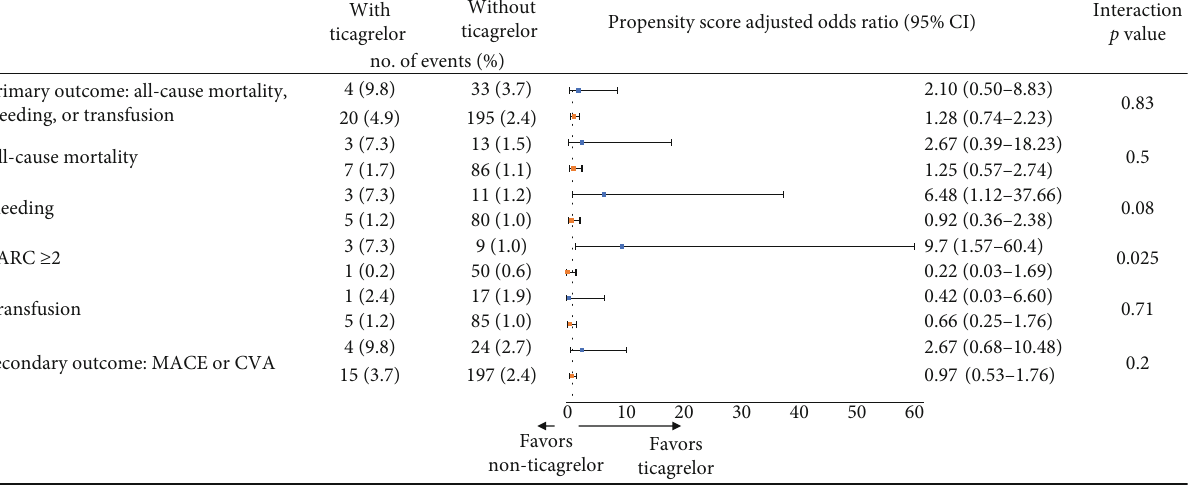
Figure 2: The association between ticagrelor use and the risk of in-hospital outcomes in patients with and without TCP. TCP: thrombocytopenia; BARC: Bleeding Academic Research Consortium; MACE: major adverse cardiovascular events; CVA: cerebrovascular